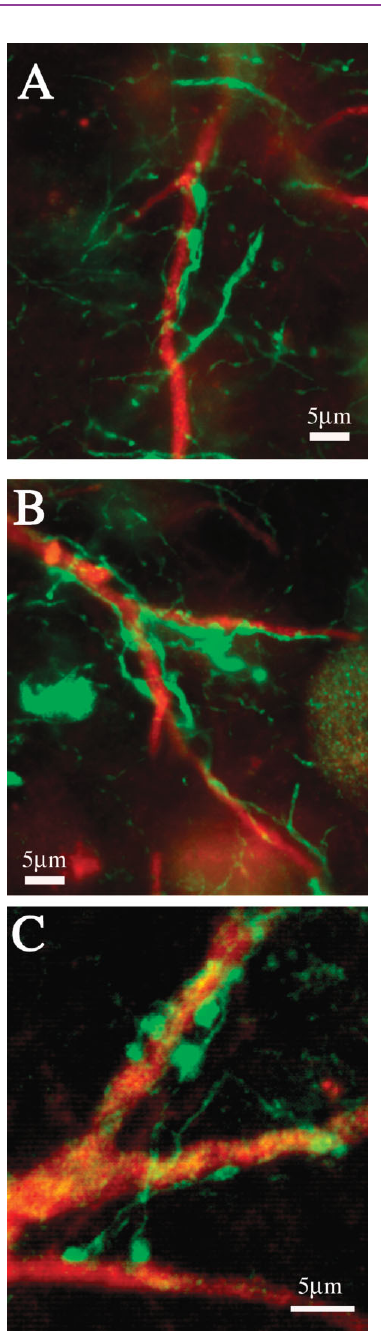
Figure 8. (A–C) Proximal dendrites of giant neurons are densely coated with PV + terminations . Higher magnification from the three boxed regions in Figures 5C and 5F